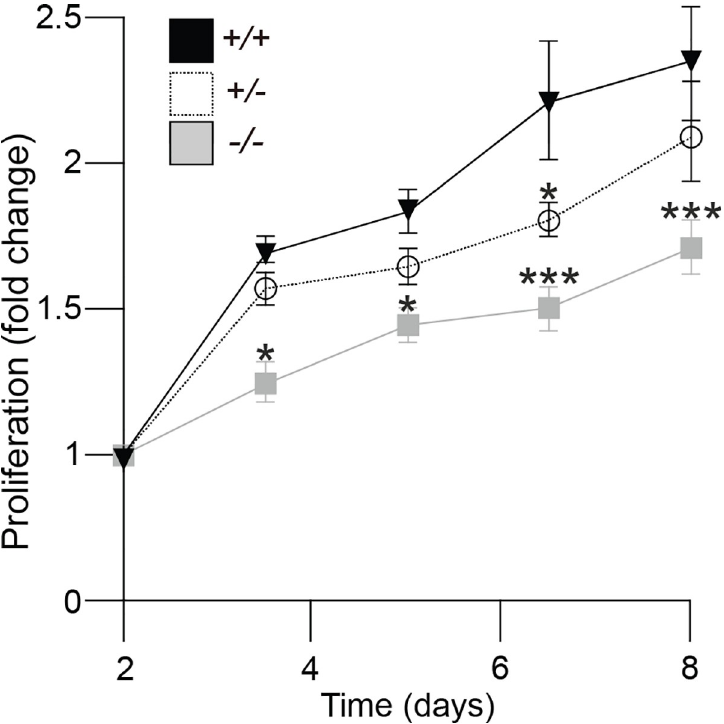
Fig 5. PIK3C2A deficiency causes delayed proliferation rates in patient-derived fibroblasts. Proliferation curve of primary fibroblasts isolated from PIK3C2A WT (+/+), heterozygous (+/-), and homozygous (-/-) individuals. Values are reported as the mean ± SEM from 3 independent experiments. � indicates p < 0.05, ��� indicates p < 0.0001.